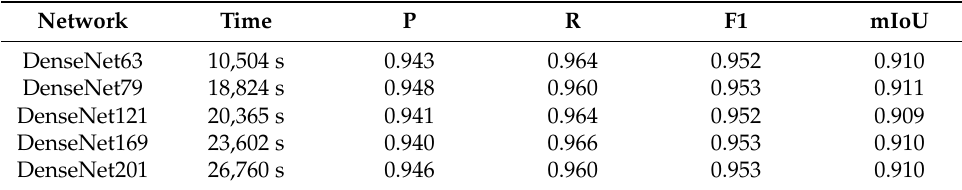
Table 1. Evaluation matrices of different DenseNet models; P refers to precision, R refers to recall, F1 refers to F1 score, and mIoU refers to mean intersection over union. The optimal value for each metric is shown boldened.